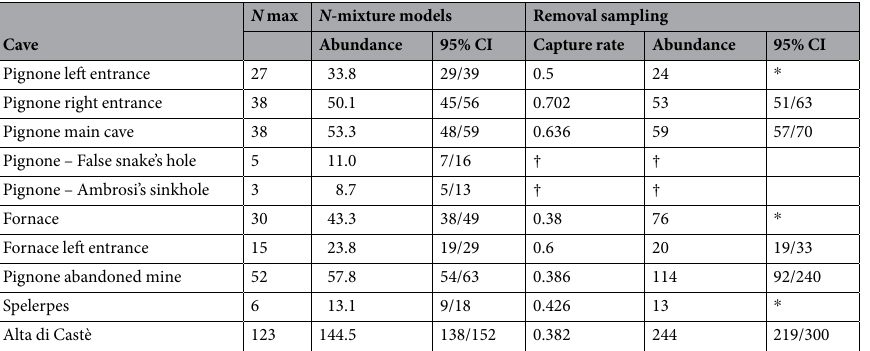
Table 1. Abundance estimates in ten populations of Hydromantes ambrosii , obtained with different approaches. N max: max number of individuals detected in one single survey session. † The method was unable to estimate population size. * Estimation of 95% CI was not